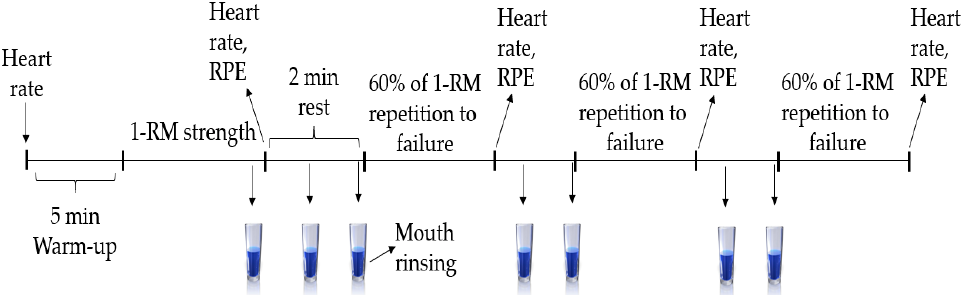
Figure 1. Schematic diagram of experimental